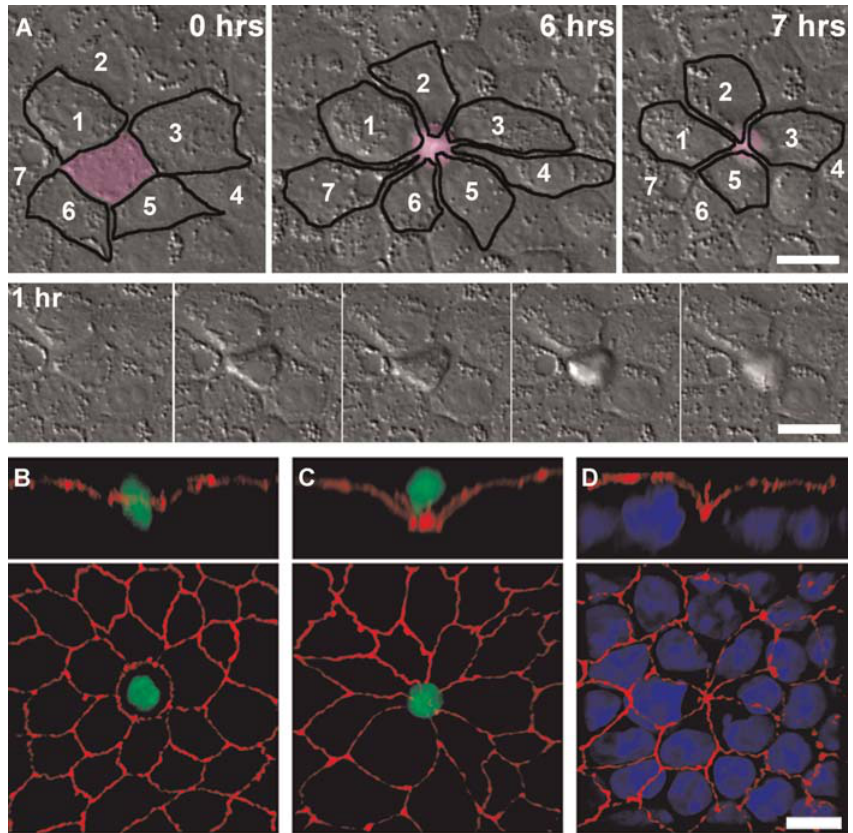
Figure 4. Multicellular Junctions Created by Cell Extrusion (A) Top panels show reorganization of cells around a site of cell extrusion monitored live by time-lapse differential interference contrast microscopy. The extruding cell is colored in purple, and adjacent cells are outlined in black to show changes in the shape and relative location of the cells over time. The cells surrounding the extruded cell are numbered to illustrate their position at the start and after resolution of the multicellular junction. The bottom strip shows the process of extrusion, beginning at hour 1 of observation, and continuing for 40 min; frames at 10-min intervals. Early (B) and late stages (C) of cell extrusion from a polarized MDCK epithelium were imaged by confocal microscopy after staining the monolayer for apoptotic nuclei with Sytox green and with antibodies to ZO-1 (red). (D) Staining of all the cell nuclei in the monolayer with toto-3 (blue) illustrates that a missing nucleus is evident at extrusion sites after cell extrusion is completed. Reconstructed Z-section panels (B–D, top) reveal the rearrangement of junctions that occurs during cell extrusion. Scale bar 10 l m. DOI: